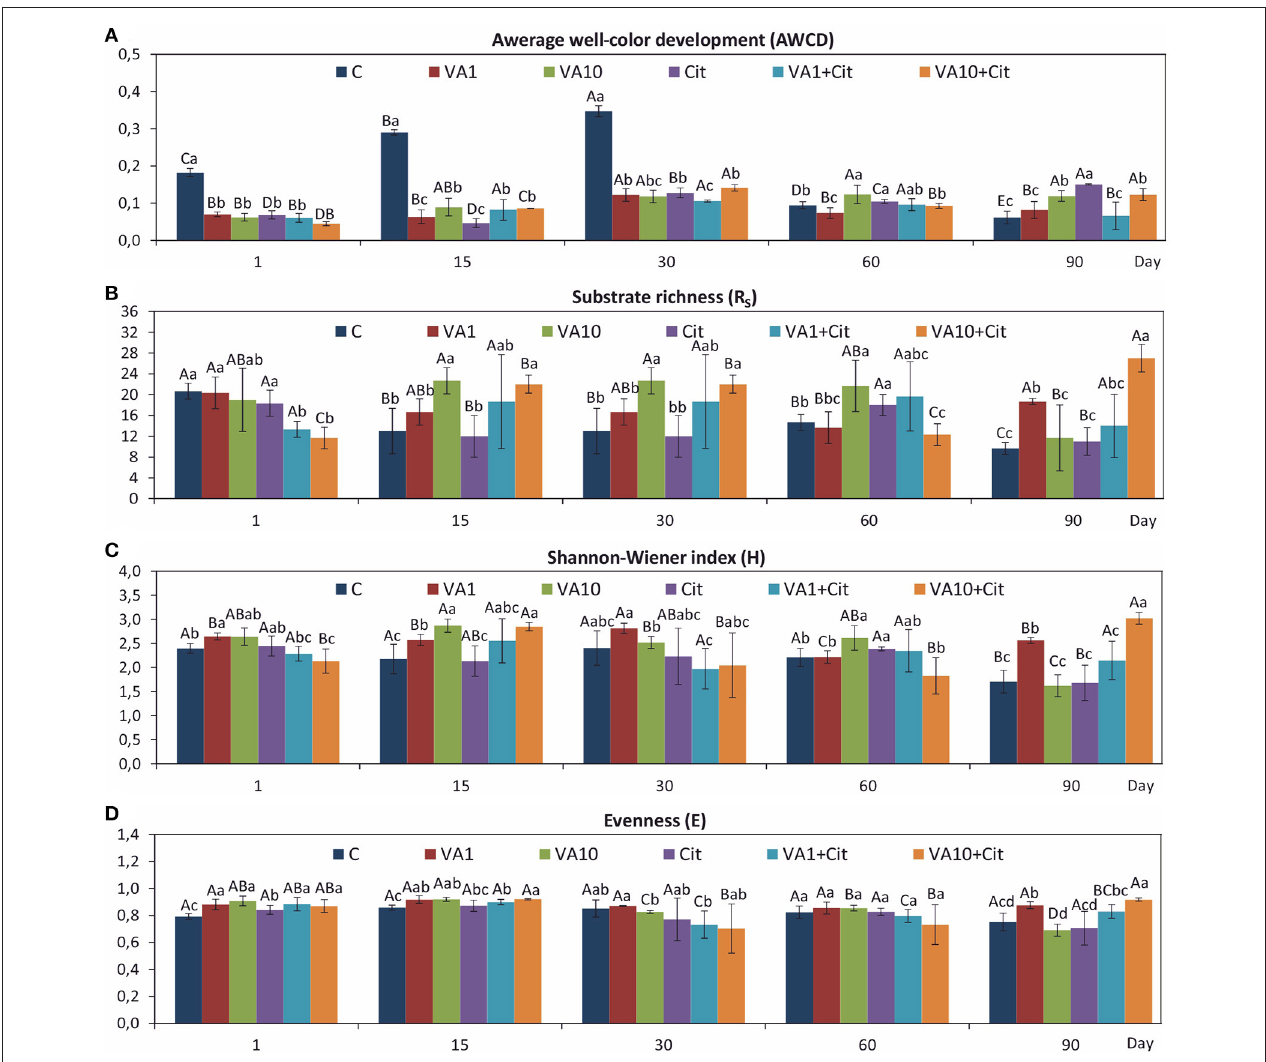
FIGURE 1 | Values of the CLPP indices: AWCD (A) , R S (B) , H (C) , and E (D) for the soil with VA and/or C . freundii obtained during the experimental period. C, control; VA1, 1mg VA/kg soil; VA10, 10mg VA/kg soil; Cit, C . freundii ; VA1 + Cit, 1mg VA/kg soil + C . freundii; VA10 + Cit, 10mg VA/kg soil + C . freundii . The data are the means with standard deviations ( n = 3). Different lowercase and uppercase letters within the values of each index indicate significant differences between treatments at the same sampling time and between sampling times within the same treatment (LSD post hoc test; P < 0.05),